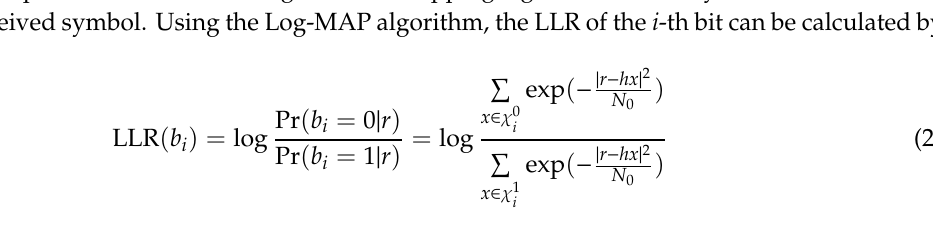
Figure 2. BICM system block diagram.